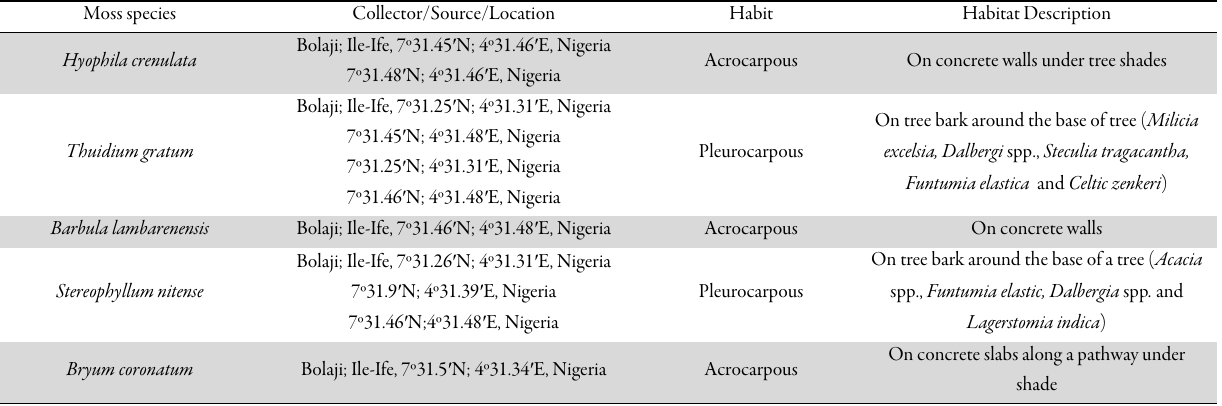
Table 1. Sources of moss species studied Moss